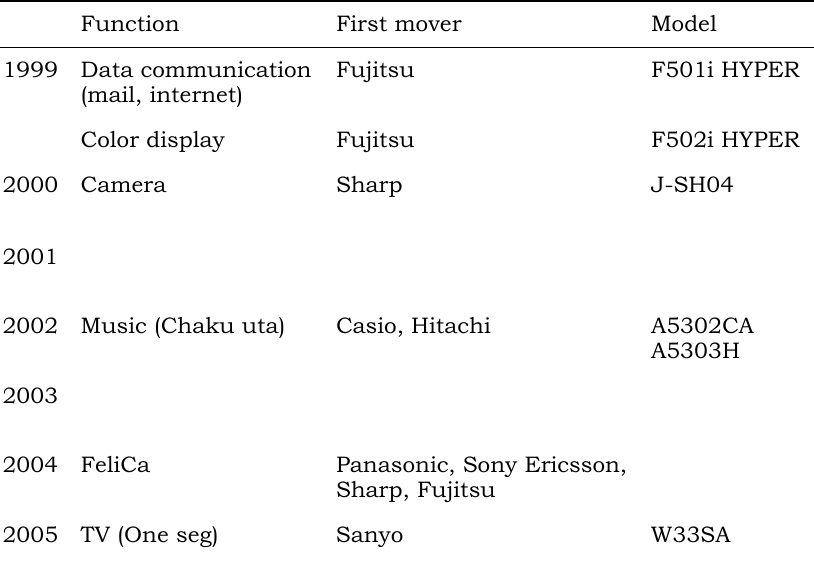
Table 1. The evolution of Galapgos ke-tai’s function